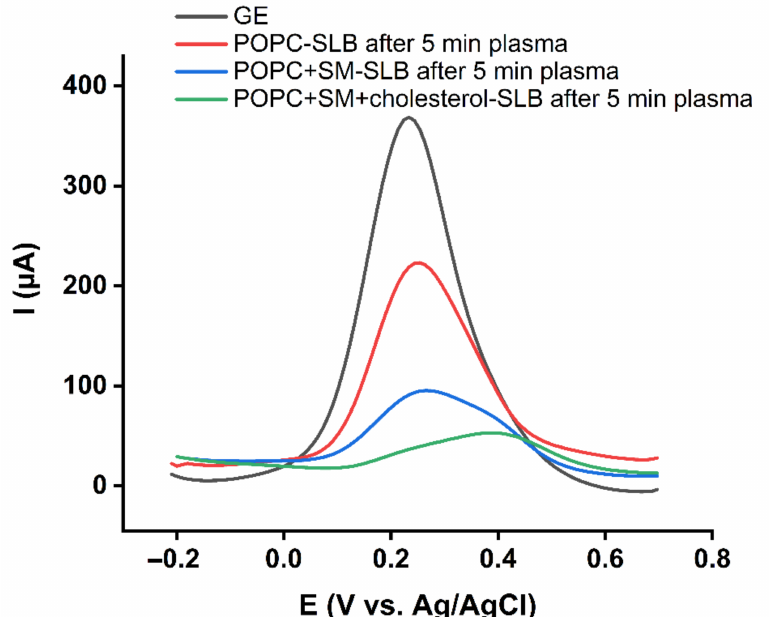
Figure 5. Differential pulse voltammograms of 10 mM K 4 [Fe(CN) 6 ] in PBS recorded for the gold electrode (GE), and symmetric lipid bilayers from POPC, POPC + SM, and POPC + SM + 10% cholesterol after 5 min plasma